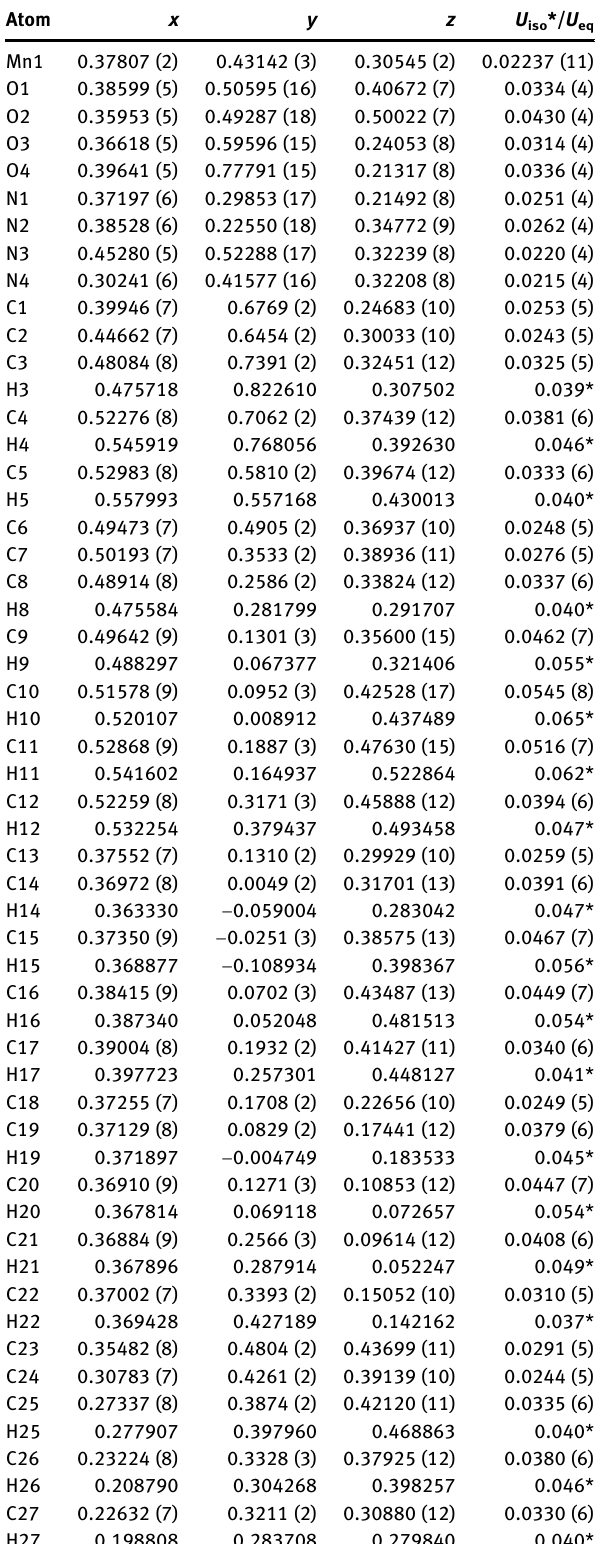
Table  : Fractional atomic coordinates and isotropic or equivalent isotropic displacement parameters (Å 